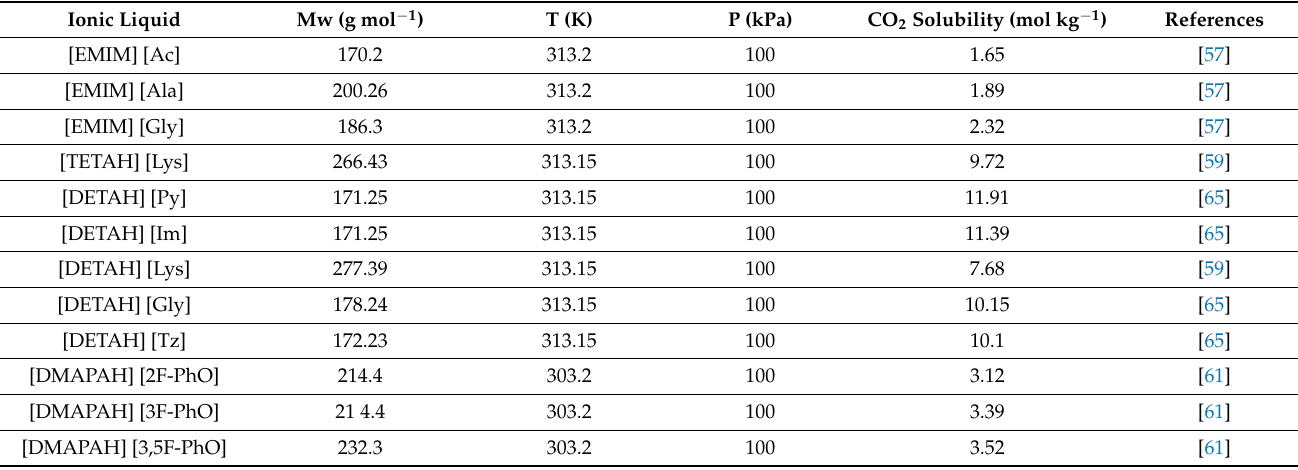
Table 3. CO 2 solubility in ionic